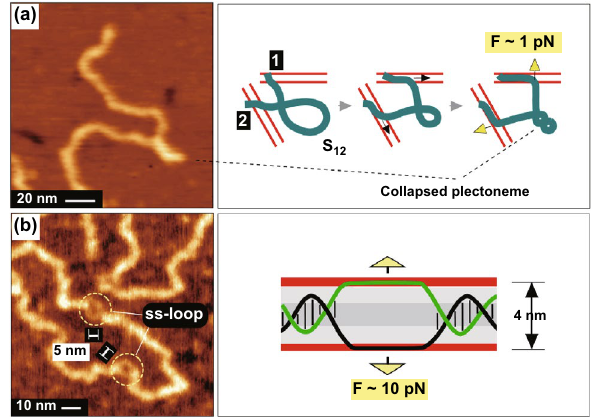
Fig. 7 AFM images (on the left) and the probable models (on the right) of the sites of the local supercoiling and melting induced by the lateral force in the surface‑adsorbed linear DNA. The positively charged rows of lamellar amines are shown by red lines. The force that controls the conformational transition is shown by yellow arrows. a A collapsed plectoneme model of the tight local supercoiling induced under the tensile force. b A model of the melting bubble sta‑ bilized by the unzipping attraction to the side lamellar